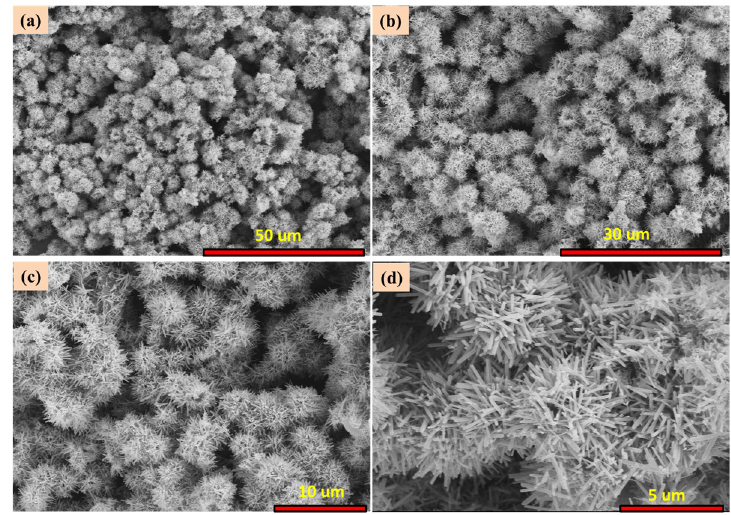
Figure 2. SEM pictures of the prepared α -MnO 2 at different magnifications ( a – d ). The EDS mapping image of the Mn and O elements has been displayed in Figure 3c and Figure 3d, respectively. The atomic percentage of the Mn and O elements was found to be 33.46 and 66.54%, whereas the weight percentage of the Mn and O elements was found to be 64.13 and 35.87%, respectively.